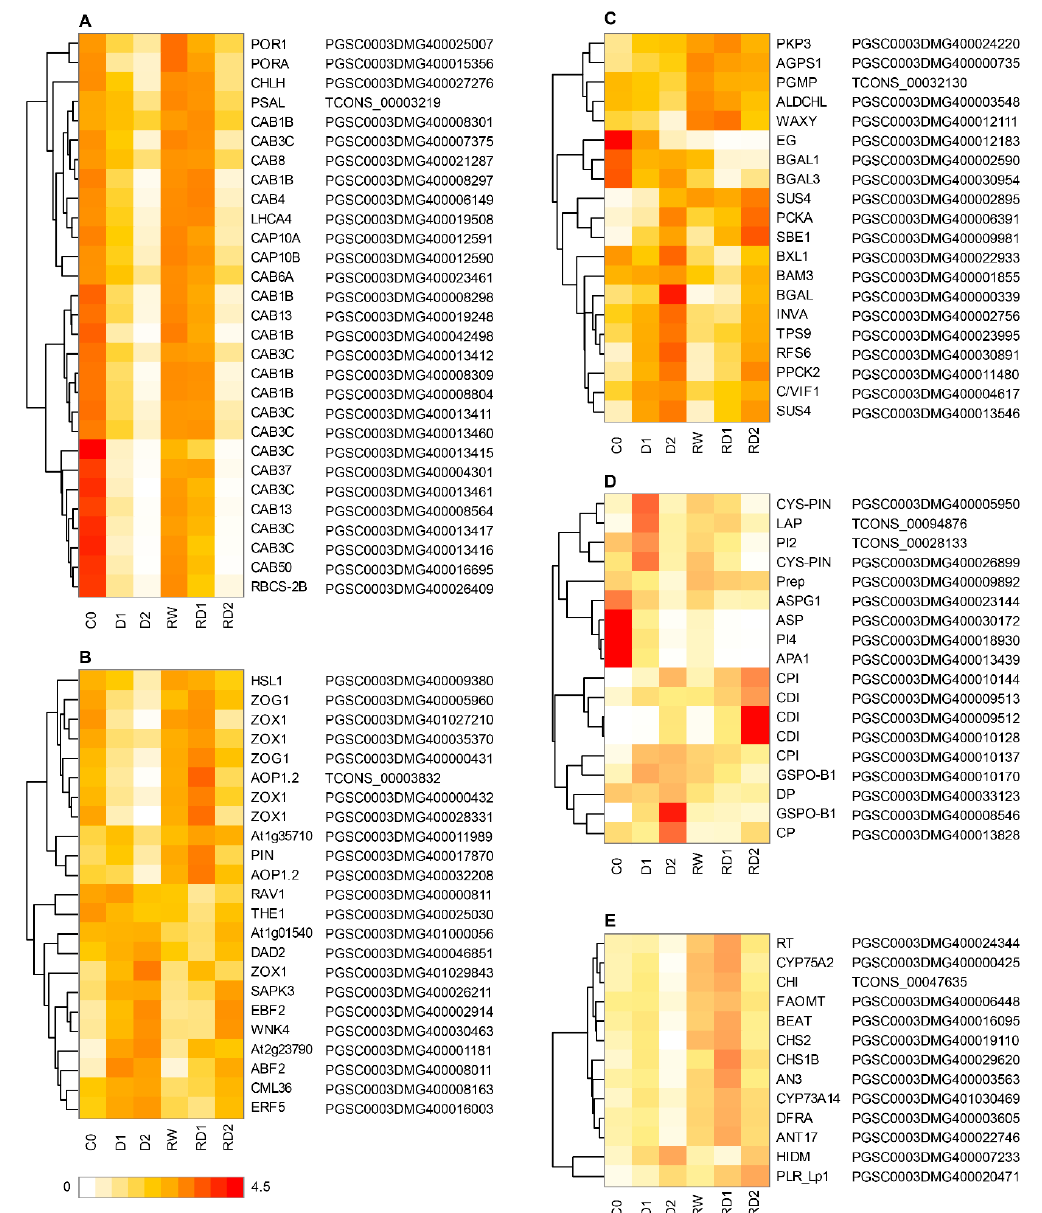
Figure 6. ( A ) The photosynthesis-related genes; ( B ) The hormone signal transduction related genes; ( C ) The glucose-metabolism-related genes; ( D ) The protease and protease inhibitor genes; and ( E ) The flavonoid-synthesis-related genes which were trained by drought.